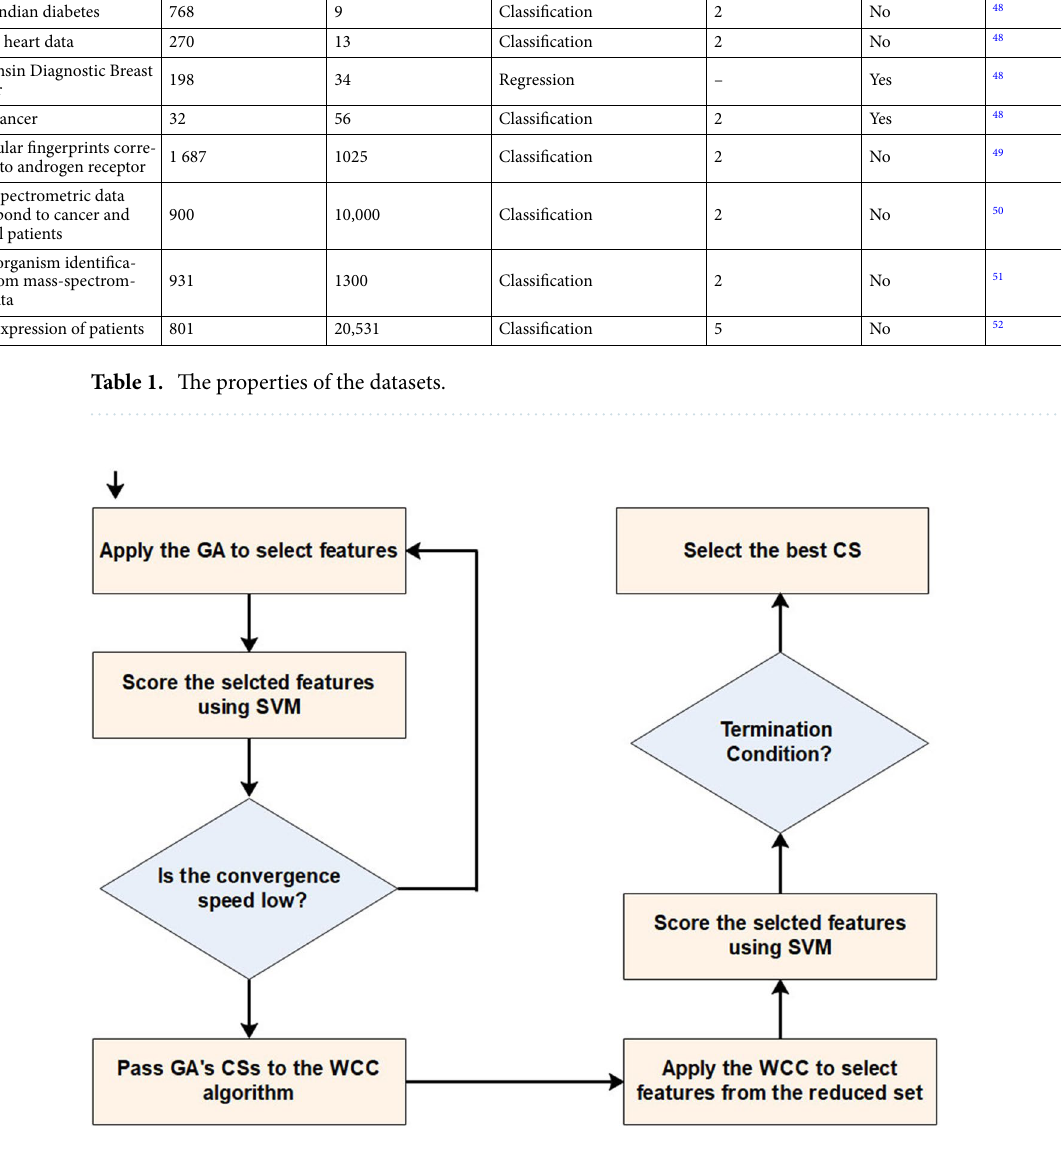
Figure 1. The framework of the proposed method based on the wrapper-wrapper feature selection technique, consisting of two phases. First, the GA confines the total number of features and then passes them towards the WCC. All the CSs are scored by the SVM. At the end of the method, the best CS is introduced as an answer to the problem. CS, candidate solution; GA, genetic algorithm; SVM, support vector machines; WCC, world competitive contests